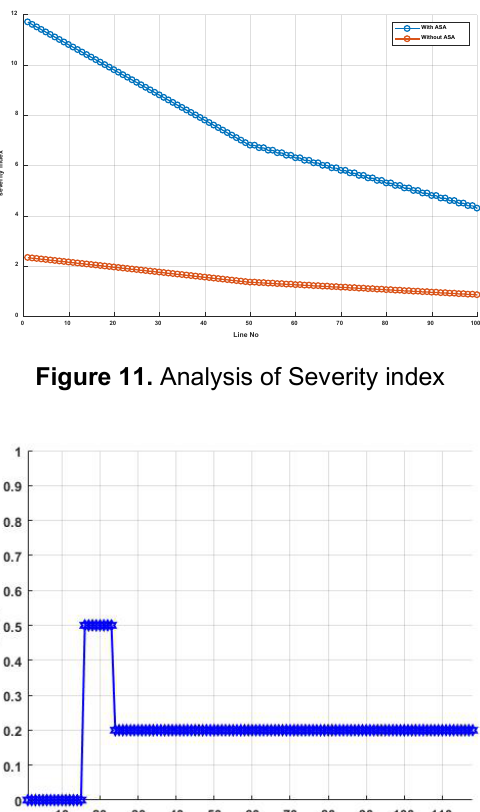
Figure 12. Analysis of LOSI